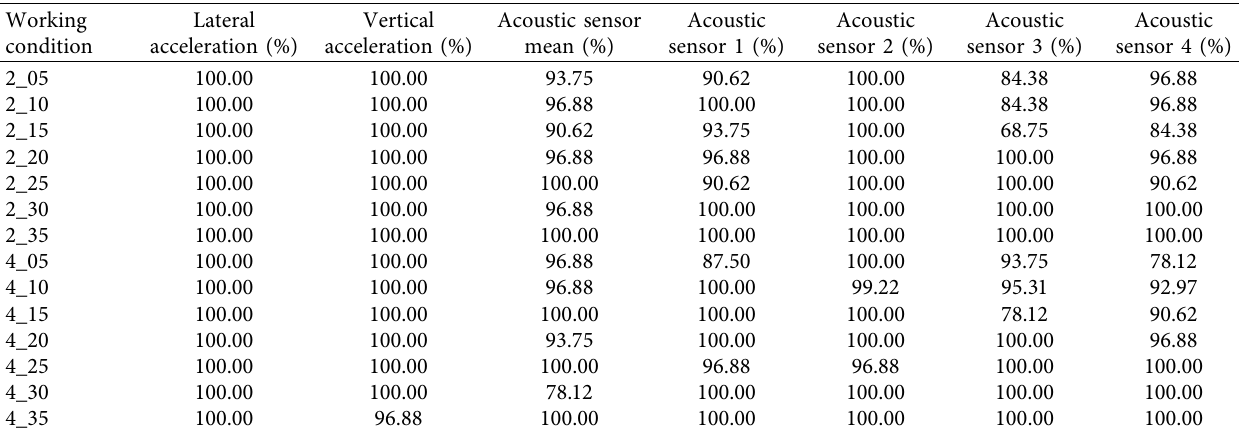
Table 14: Classification accuracy of AVEP data under single working condition.